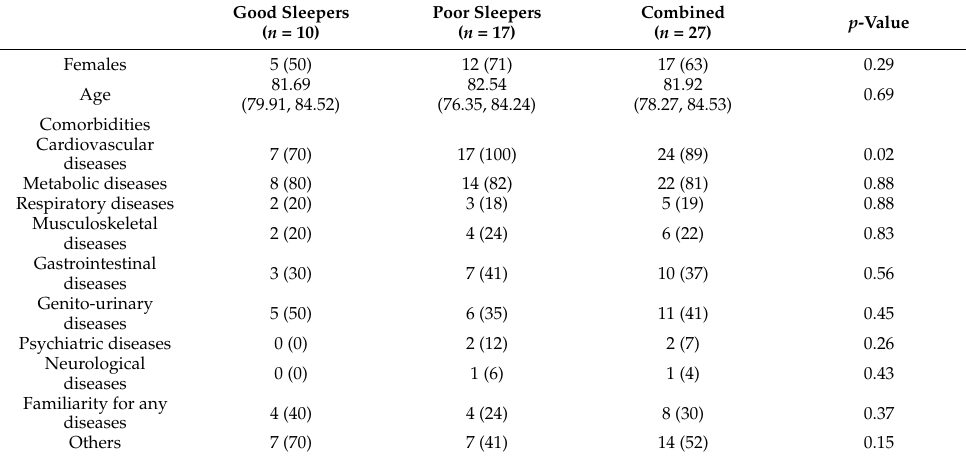
Table 1. Characteristics of the study population. Continuous data are reported as median (I, III quartiles), categorical data are reported as absolute numbers (percentage). Good sleepers are subjects with a Global PSQI Score equal to or less than 5 points, poor sleepers are subjects with a Global PSQI Score higher than 5 points.